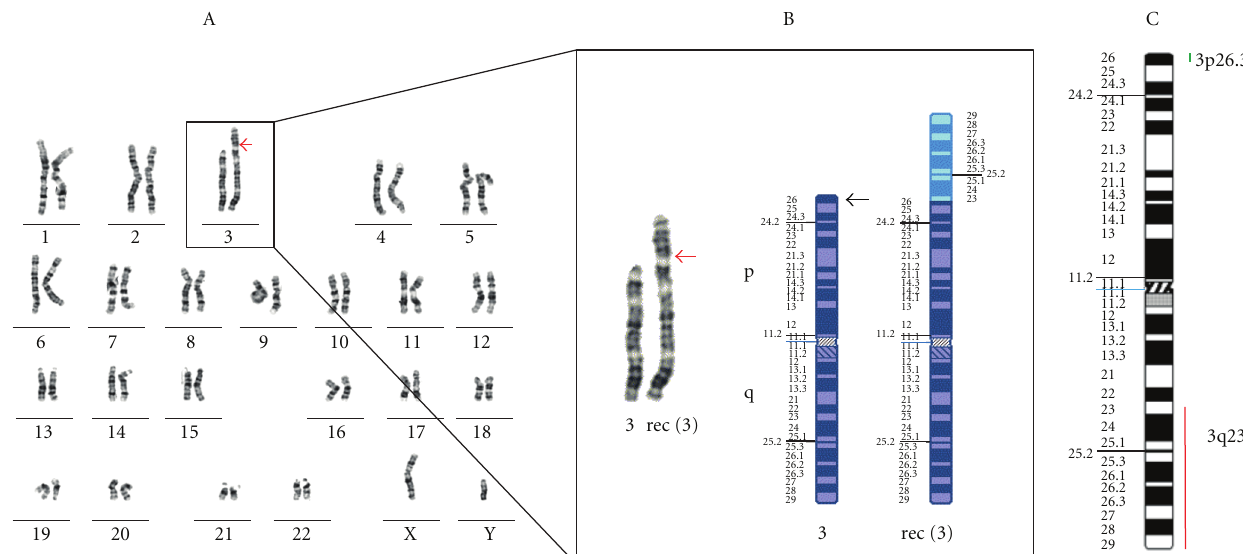
Figure 1: Karyotype and chromosome 3 ideogram of the proband. Panel A shows the karyotype of the proband, 46,XY,rec(3)dup(3q)inv(3)(p26.3q23)mat.arr 3p26.3(56,669-1,850,707)x1,3q23q29(141,829,104-199,355,203)x3. Panel B shows the normal and derivative chromosomes 3, together with an associated ideogram. Panel C is a summary ideogram of the regions of chromosome 3 that are duplicated and deleted in the